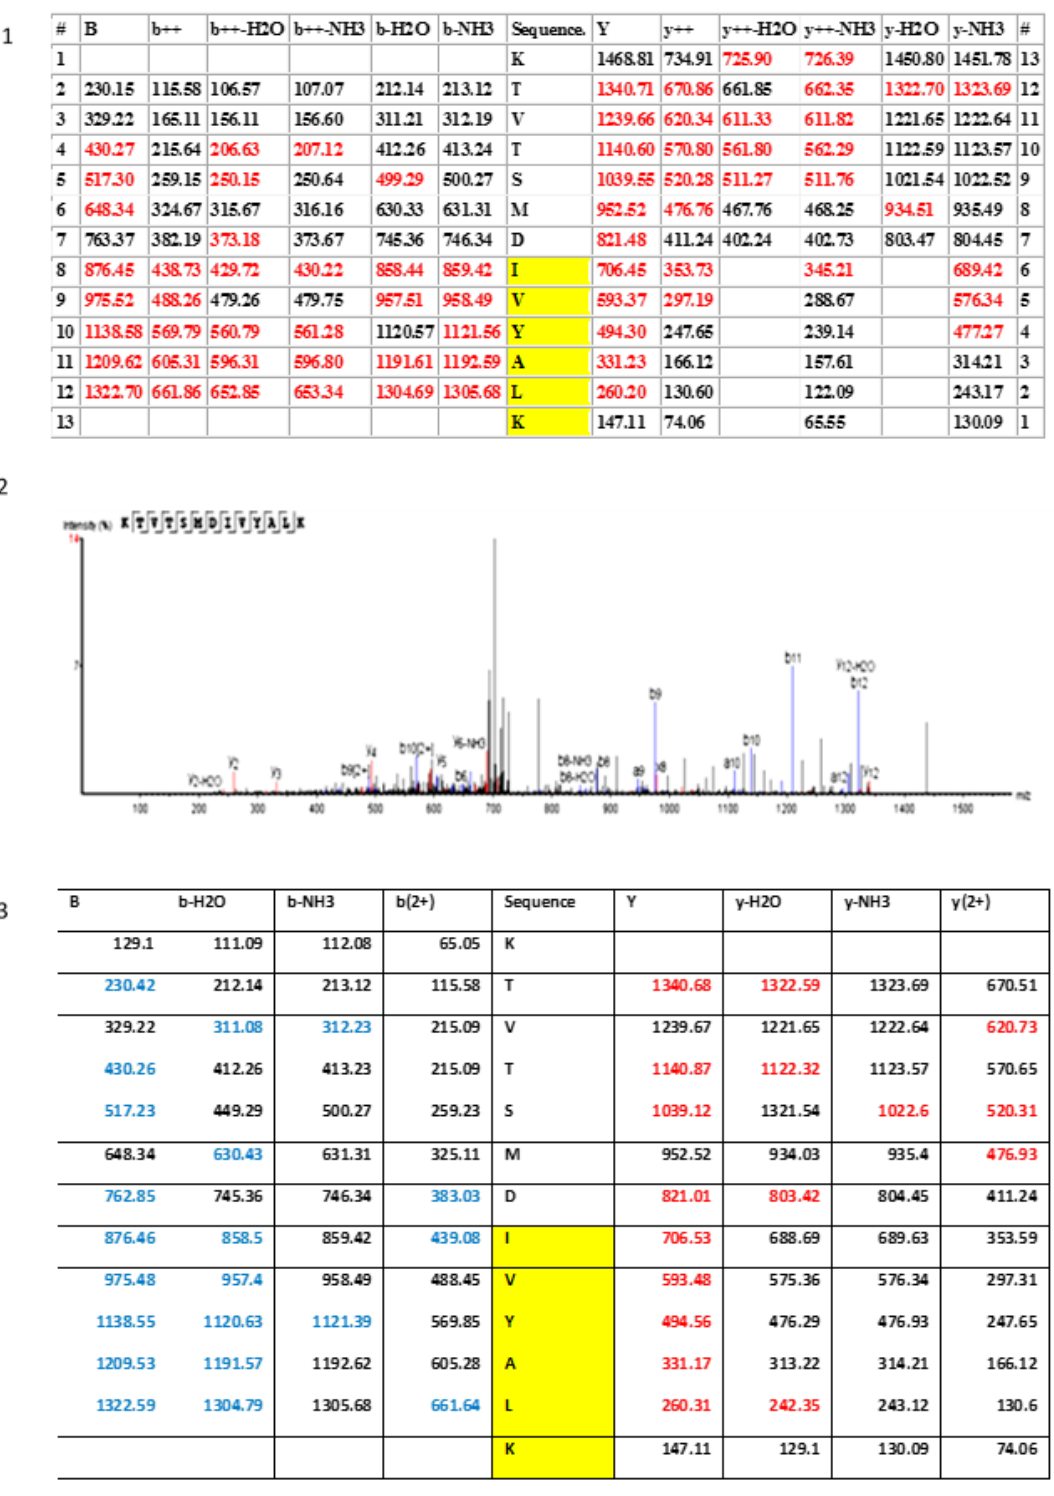
Figure 10. Mass spectrometry fragmentation patterns of the histone H4 variant (IVY). Section 1 and section 2 illustrate the fragmentation table and the spectrum (PEAKS software) of the ancestral variant of the histone H4 peptide KTVSMDIVYALK, respectively. Section 3 is the fragmentation table of the synthetic peptide that was synthesized and used to validate the KTVSMDIVYALK identification. Fragment ions that matched the spectrum in both the biological and synthetic spectrum are highlighted in colour. Red = xyz ions; blue = abc ions. The yellow region IVYALK indicates the histone H4 variant that was detected, along with the conventional histone H4, in the human cells. The same pattern IVY is also present in the histone H4 biology of polydnaviruses.